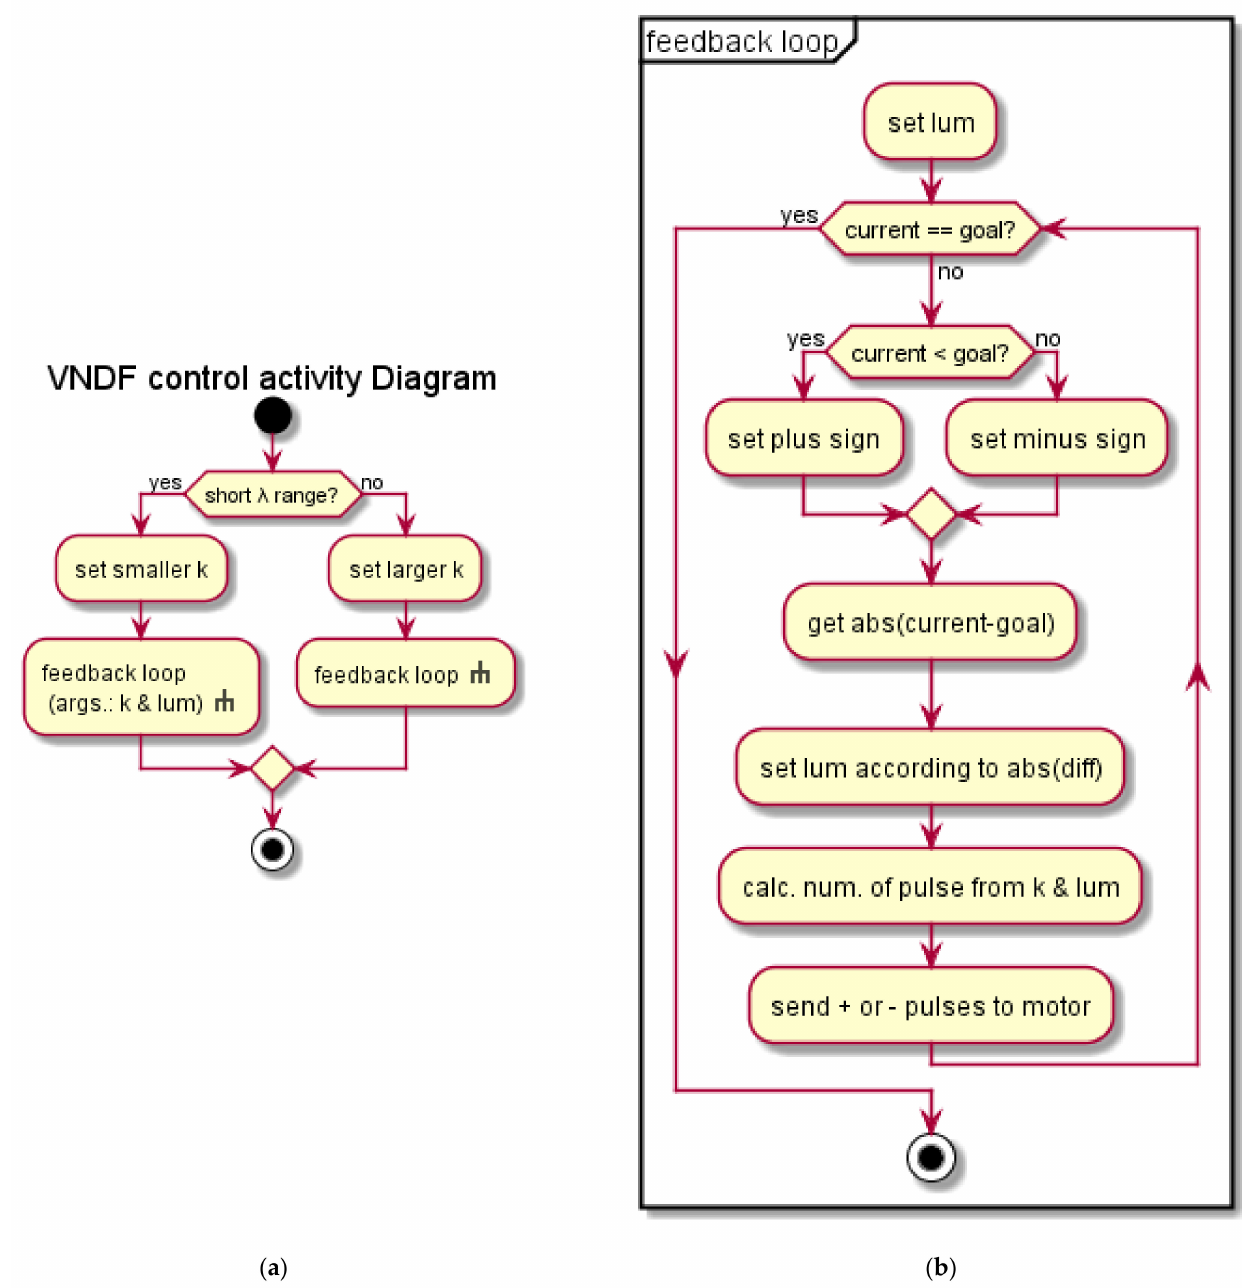
Figure 3. A flow chart showing the main parts of the feedback algorithm ( a ) with the called sub-routine ( b ). The name of the sub-routine is feedback loop. For the want of space, the number of the energetic (wavelength) regions was limited to two regions, although the actual number of the regions was five. The symbol λ depicts the wavelength (energy) of the detection. The flow chart only concerns the communication between the motor-driver and the RISC. Values of k and lum are related to the weights used to determine the number of the pulses sent to the stepping motor. Arguments were abbreviated as “args”